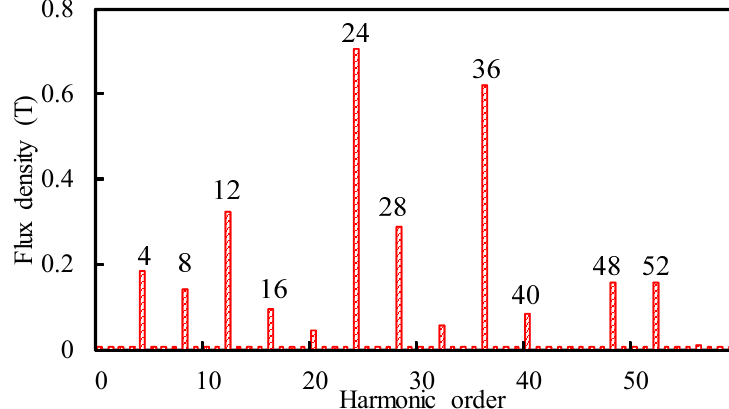
Figure 3. Fourier analysis of magnetic flux density in air gap. Table 1. Machine parameters.